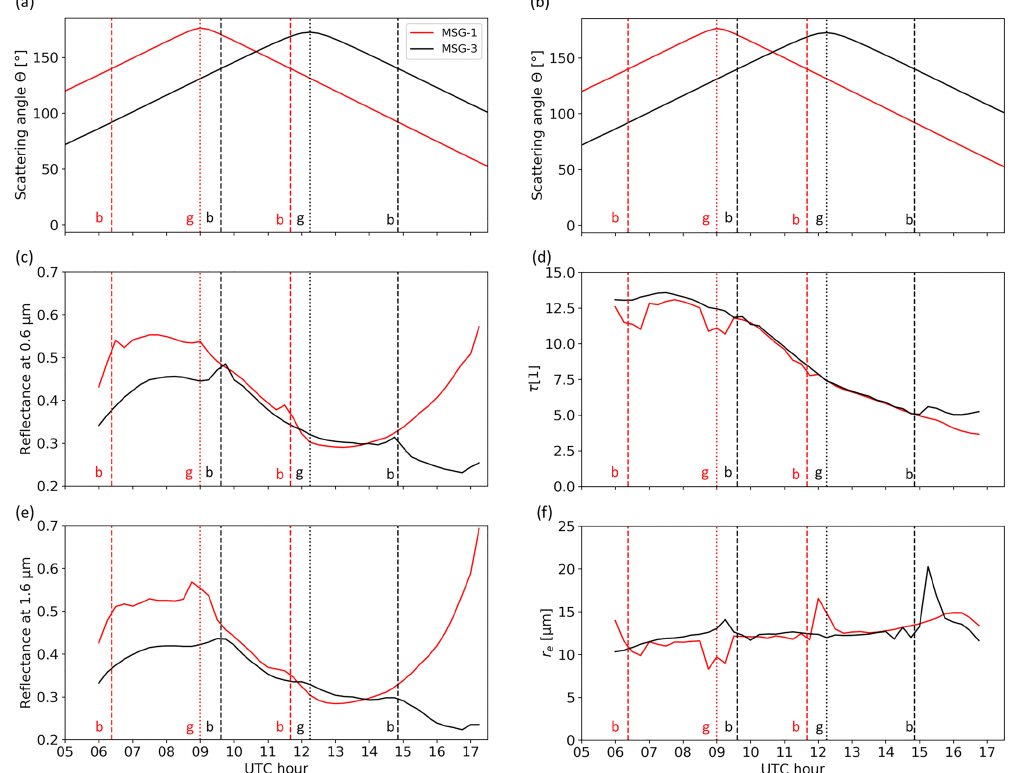
Figure 4. Diurnal evolution of average cloudy-sky reflectances observed from SEVIRI at 0.6µm (c) and 1.6µm (e) and CPP output τ (d) and r e (f) over the southeastern Atlantic region on 7 March 2017. Scattering angles (a, b) are shown twice for visualization purposes. All data are shown separately for MSG-1 (red lines) and MSG-3 (black lines). The CPP output is based on retrievals with ν e = 0 . 15. Dotted vertical lines correspond to the maximum scattering angles, highlighting the cloud glory region, while dashed vertical lines are drawn at 140 ◦ scattering angles, roughly the cloud bow regions. Letters “b” and “g”, corresponding to cloud bow and glory, respectively, are included next to the vertical lines to facilitate